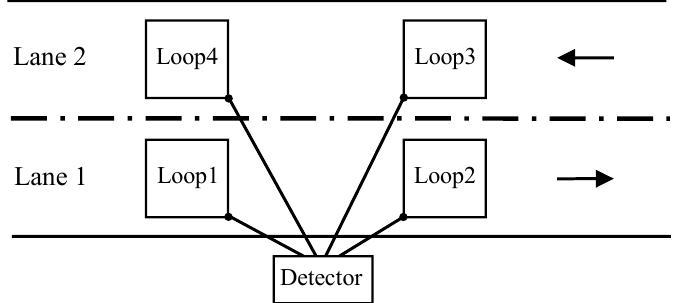
Figure 12. Interconnections from the inductive loop to the detector.